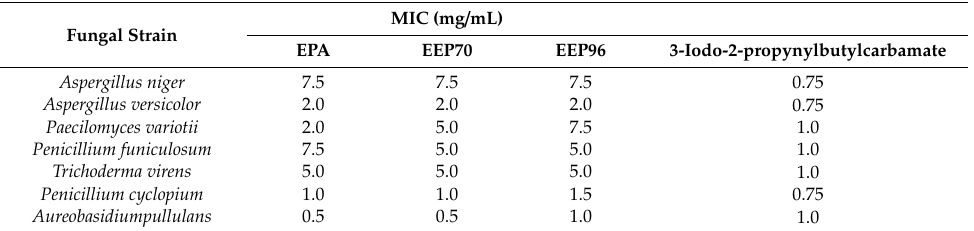
Table 6. Minimal inhibitory concentration (mg / mL) of propolis extracts.